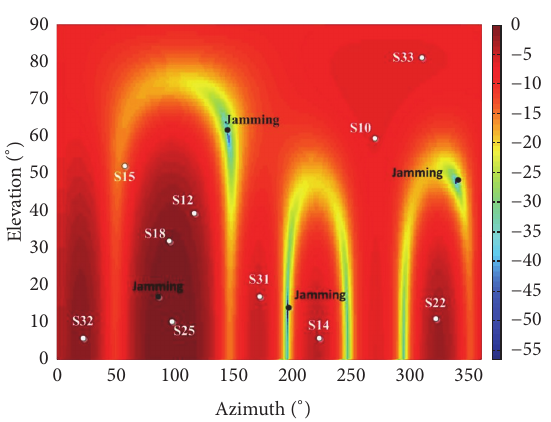
Figure 17: Beams and nulls 2D pattern of the proposed method according to the scenario in Table 2 and Jamming Scenario in Section